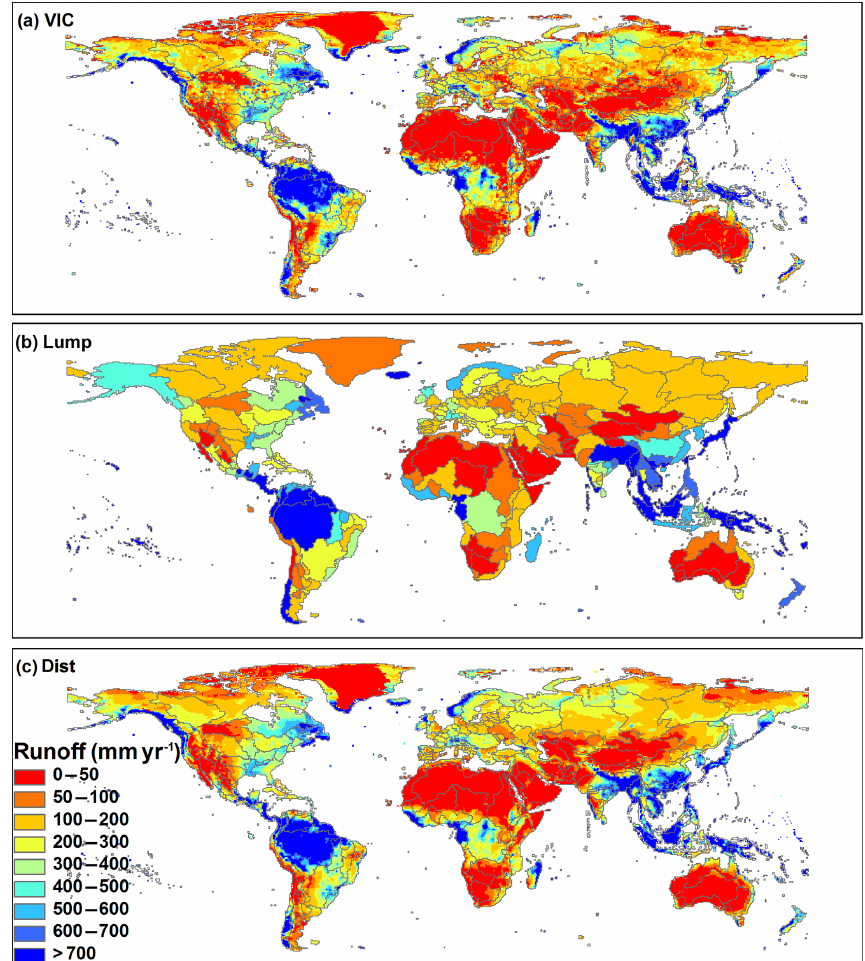
Figure 5. Spatial patterns of long-term annual total runoff (mmyr − 1 ) during 1971–1990 across the global 235 basins: (a) VIC runoff product, (b) total runoff estimates from the lumped abcd scheme (Lump: lumped), and (c) total runoff estimates from the distributed abcd scheme (Dist: